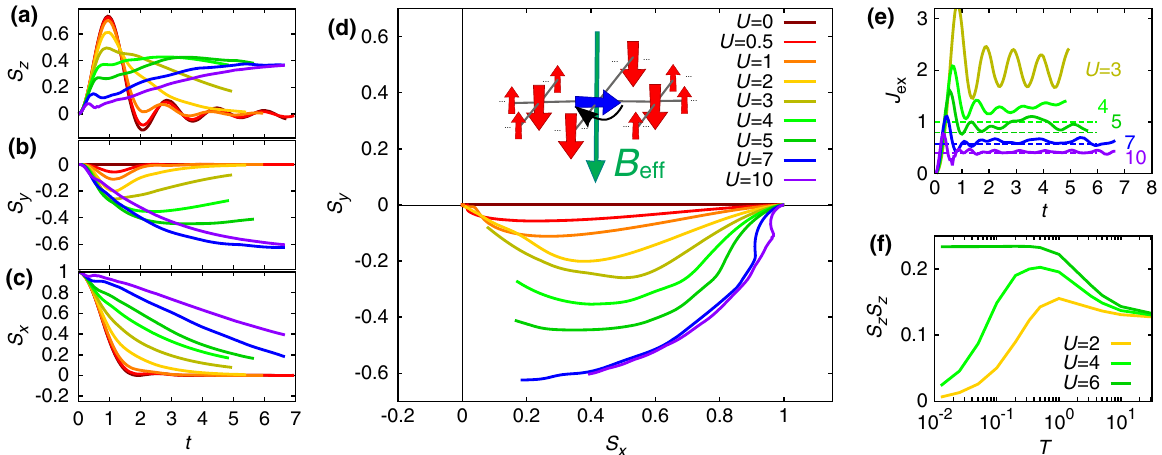
FIG. 4. Dynamics at a probe site o , where the spin is initially flipped to the x direction. (a) – (c) Expectation values h S z ð t Þi , h S y ð t Þi , and h S x ð t Þi for various values of U [see legend in (d)]. (d) Trajectory of the spin h S i in the S x - S y plane. The inset illustrates the initial state, with one spin flipped to the x direction, and the effective exchange field. (e) Effective exchange interaction, d ϕ ð t Þ =dt= j M ϕ ð t Þ ¼ arctan ð S =S S S U ¼ 3 ; 4 ; 5 ; 7 ; 10 . The dotted lines correspond to the perturbative value of the y x Þ is the angle in the x - y plane, for 4 J 2 =U . (f) Temperature-dependent local moment in equilibrium, defined by ð 1 = β Þ exchange interaction, J ex ¼ (cid:2) obtained using a continuous-time quantum Monte Carlo impurity